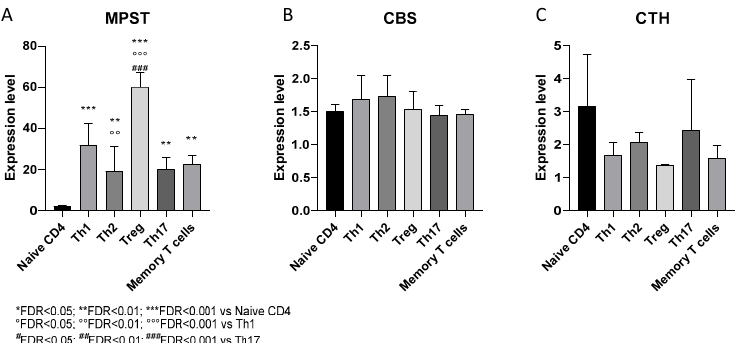
Figure 5. Expressions of the H 2 S-producing enzymes in human CD4 + T cell subsets. The expression levels of Mercaptopyruvate Sulfurtransferase (MPST) ( A ), Cystathionine Beta-Synthase (CBS) ( B ), and Cystathionine Gamma-Lyase (CTH) ( C ) were evaluated in human CD4 + T cell obtained from the peripheral blood mononuclear cells (PBMCs) of healthy donors, by interrogating the